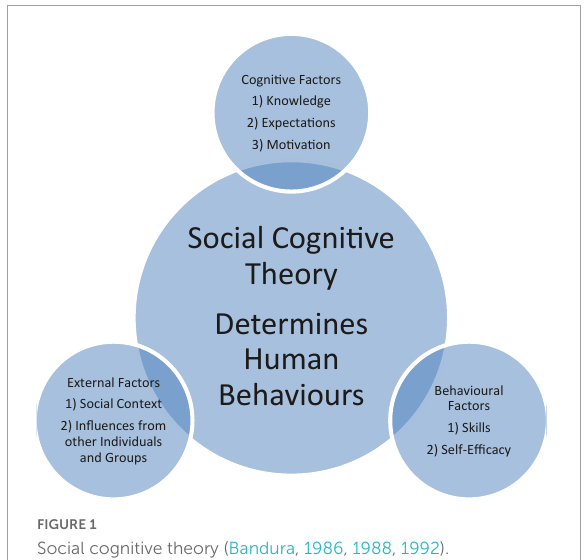
FIGURE1 Social cognitive theory (Bandura, 1986, 1988, 1992).